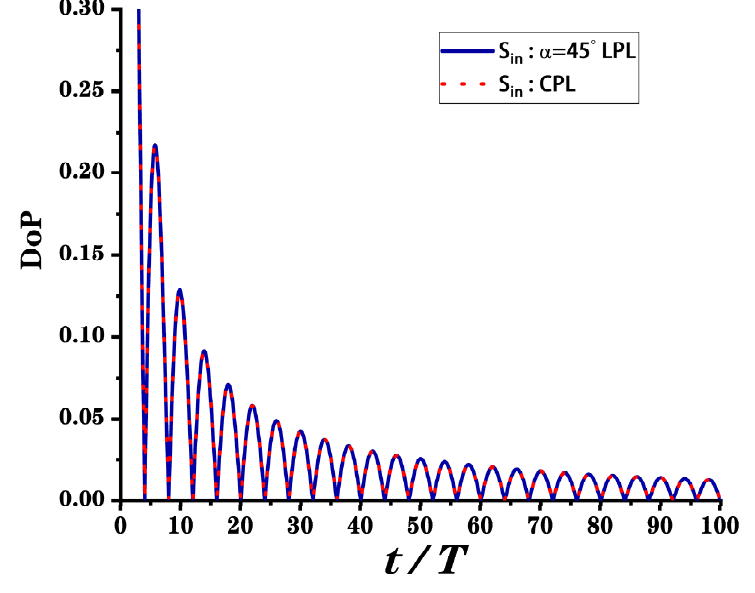
¯ Figure 6. The DoP of S out with θ = 0 and X = π t / 2 T . The blue solid line is the result when the incident light is linearly polarized light with polarization direction angle α = π / 4 ; additionally, the red dotted line corresponds to the result when the incident light is circularly polarized light. The above two results are the same. LPL: linearly polarized light; CPL: circularly polarized